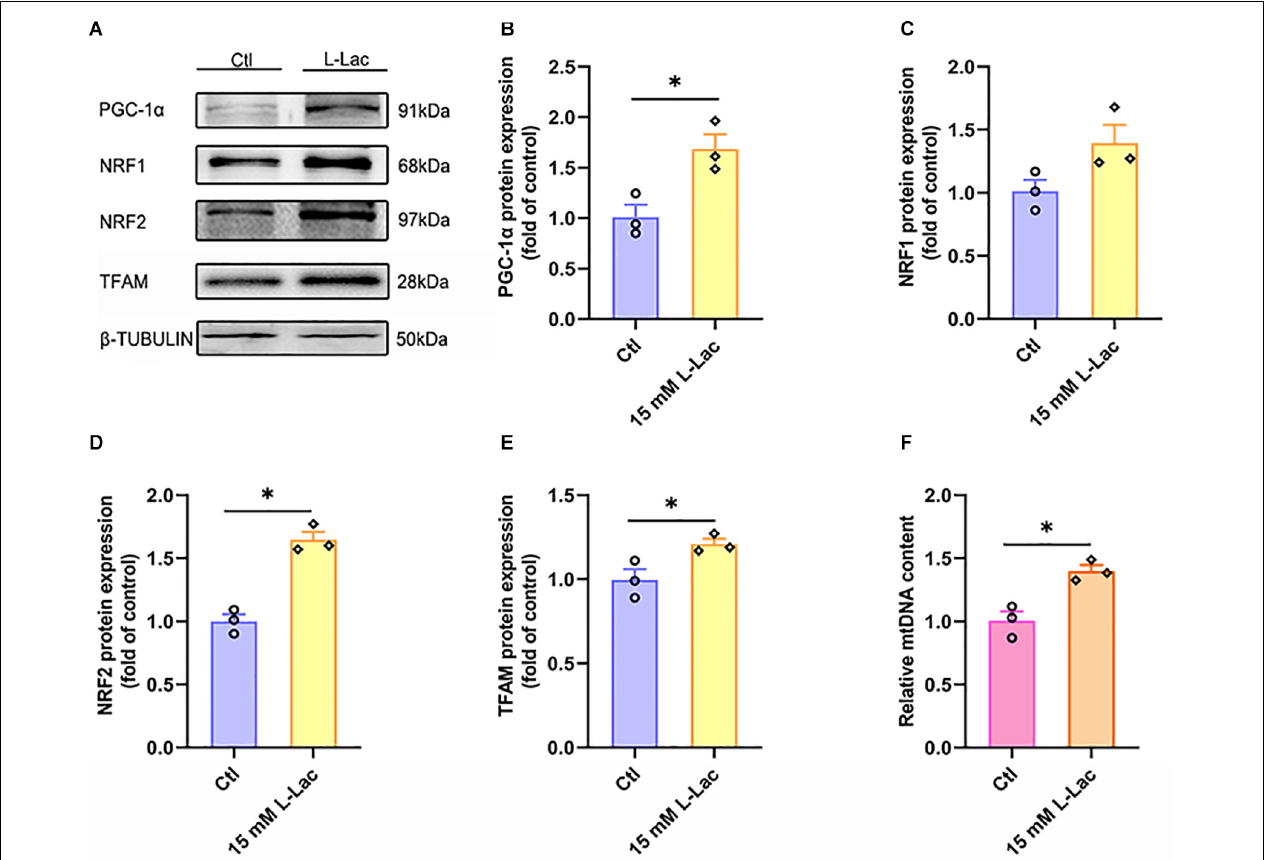
FIGURE 11 | Lactate enhanced mitochondrial biogenesis signal and increased mitochondria DNA copy number in primary hippocampal cells. The peroxisome proliferator-activated receptor γ coactivator-1 α (PGC-1 α ), nuclear respiratory factors 1 (NRF1), nuclear respiratory factors 1 (NRF2), and transcription factor A (TFAM) were determined by WB to observe the effect of lactate on mitochondrial biogenesis signals in primary hippocampal cells. The mt-Cytb level was determined by RT-PCR to evaluate mitochondria DNA copy number after the L-lactate treatment in primary hippocampal cells. (A) Representative WB image. (B) PGC-1 α protein expression. (C) NRF1 protein expression. (D) NRF2 protein expression. (E) TFAM protein expression. (F) mt-Cytb level. TUBULIN and Cycs as the loading control. N = 3 in three independent experiments. ∗ P ≤ 0.05 as compared with the Ctl group by non-parametric tests. Values are expressed as mean ± standard error of